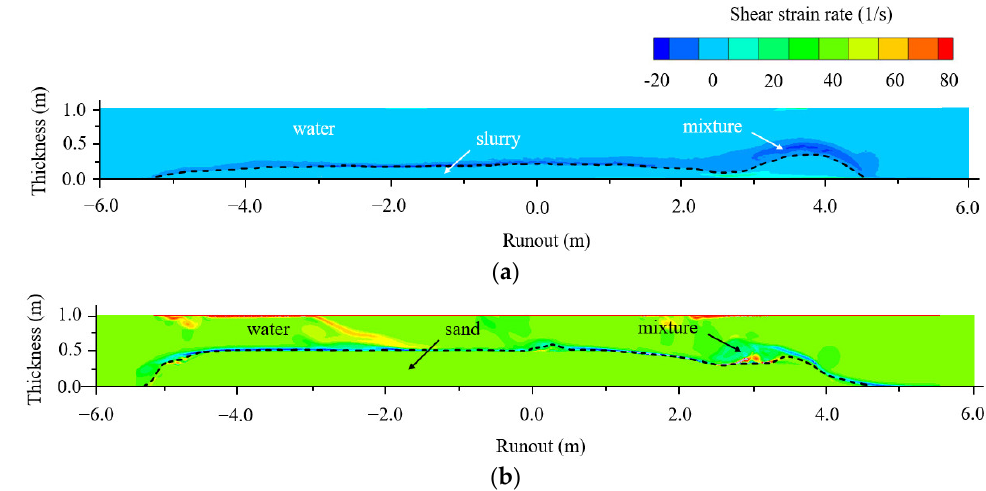
Figure 10. Shear strain rate contour at 6 s. ( a ) The mixture model. ( b ) The VOF model.